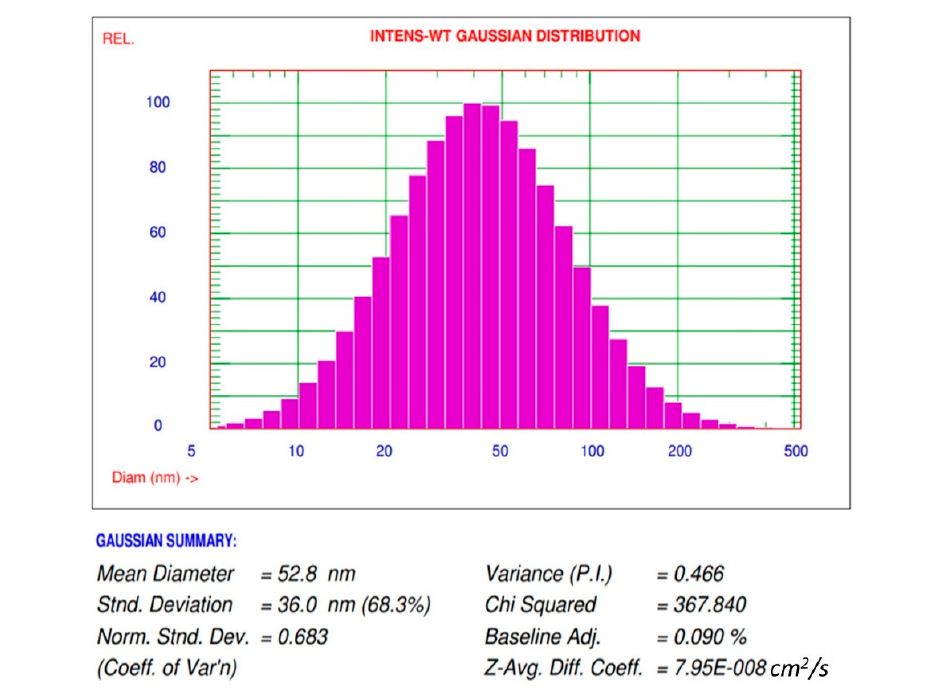
Figure 2. Particle size distribution of AgNPs synthesized using M. indica aqueous leaf extract.